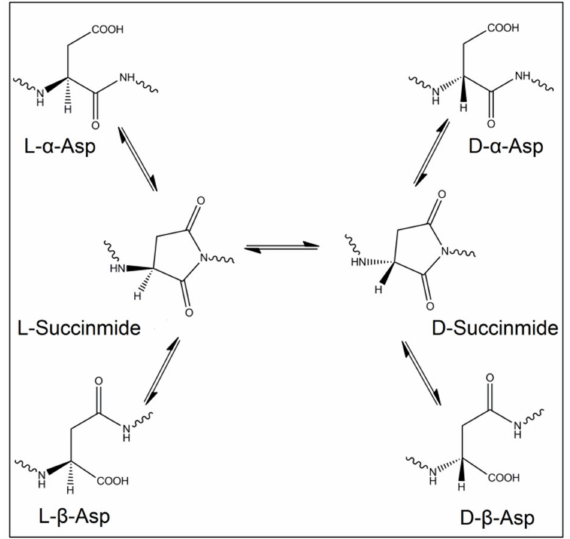
Figure 1. Scheme of the spontaneous isomerization of the four isomers of Asp through the succin- imide